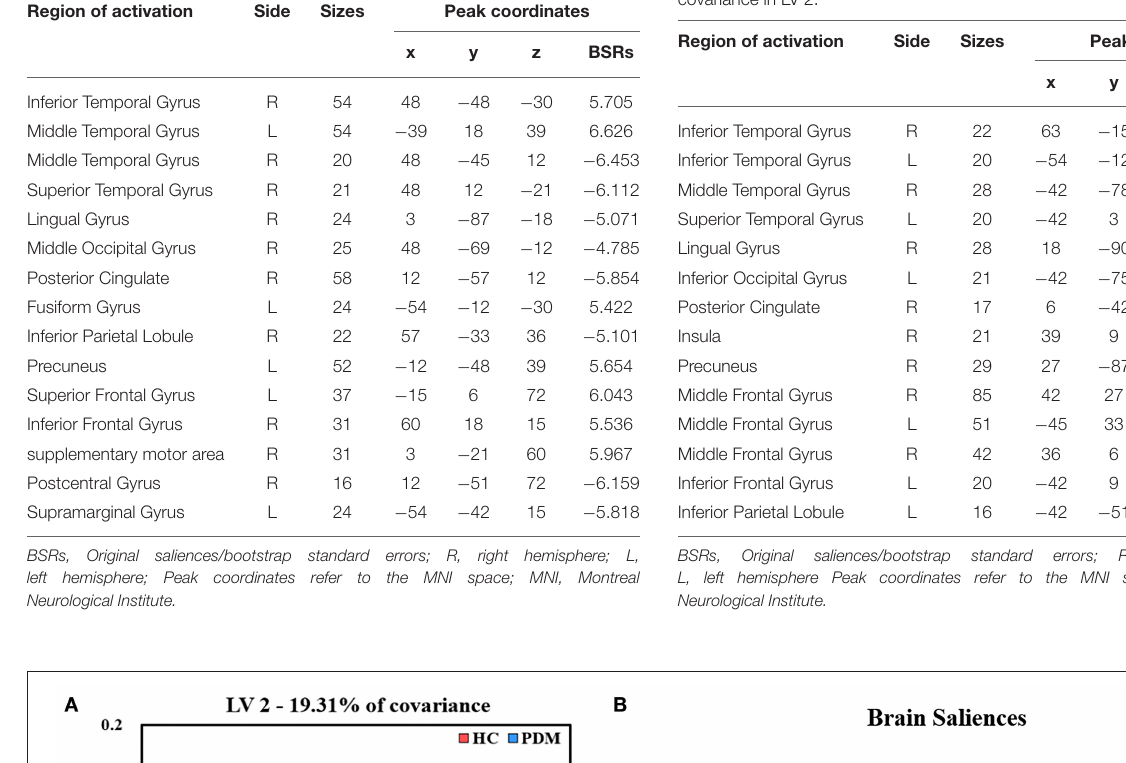
TABLE 4 | Brain regions with reliability contributions to the behavioral brain covariance in LV 2.